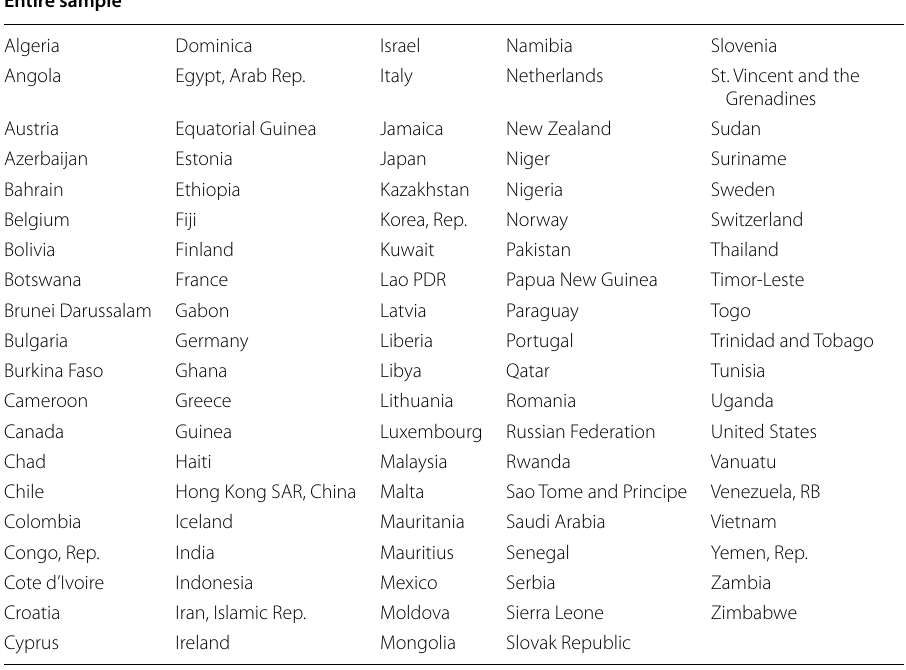
Table 7 List of the 99 countries contained in the entire sample Entire